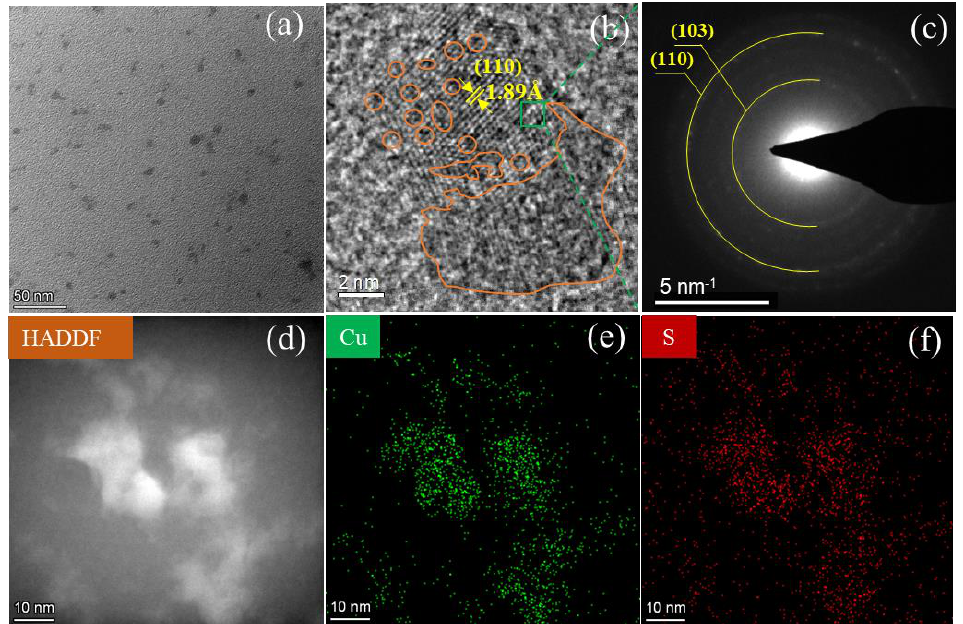
Figure 4. ( a ) TEM image of c-CuS. ( b ) HRTEM image of c-CuS. ( c ) SAED image of c-CuS. ( d ) HADDF image of c-CuS. ( e ) Cu and ( f ) S element mapping images of c-CuS (Prepared condition of c-CuS was the concentration of 1/2 mmol·L −1 and the Cu:S raw material ratio of 1:1 by using a single-jet liquid-phase sulfidation method).